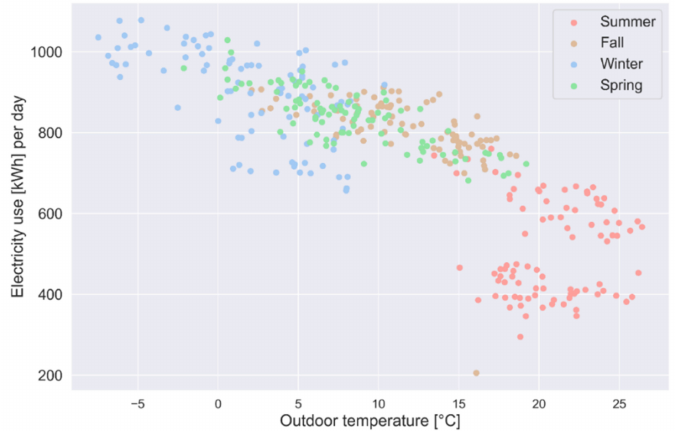
Figure 12. Daily electricity use in the apartments versus average outdoor